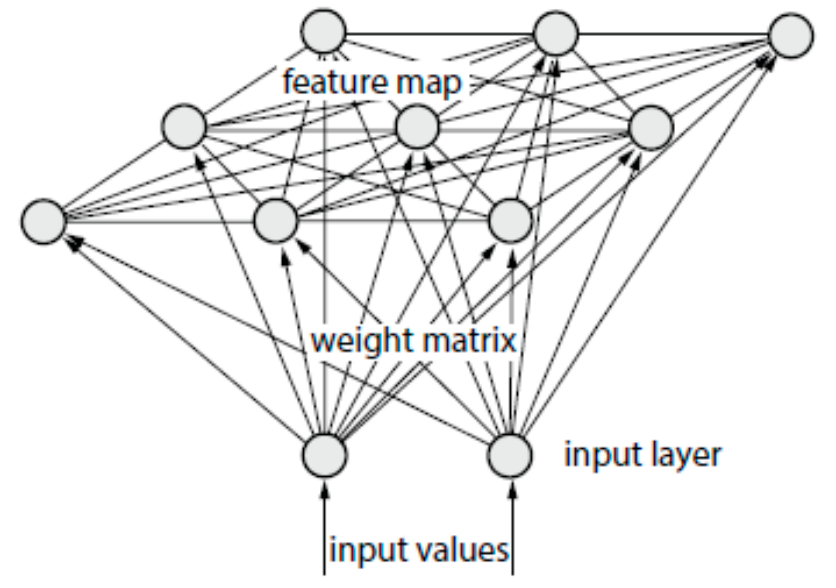
Figure 5. SOM Figure 5. SOM Framework.